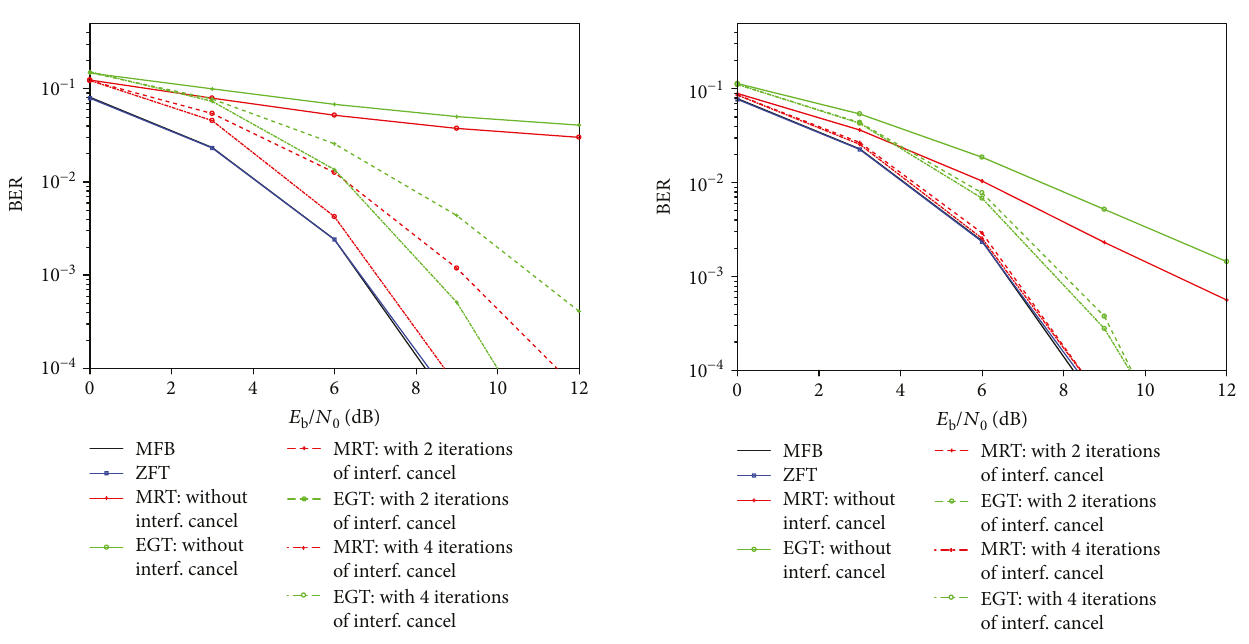
Figure 6: BER results with 128 × 8 using ideal channel estimation. Figure 5: BER results with 32 × 8 using ideal channel